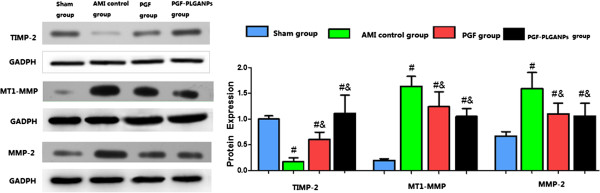
Content changes of TIMP-2, MT1-MMP, and MMP-2 detected by western blotting. A: Representative Western blots, showing bands of TIM-2, MT1-MMP and MMP-2 in myocardial specimens collected from the indicated groups. B: Bar graphs, showing the densitometric data corresponding to A. Symbols indicate significant differences (P < 0.05) from the control group (#), from the non-treatment AMI group (&), and from the nude PGF group (※), respectively.